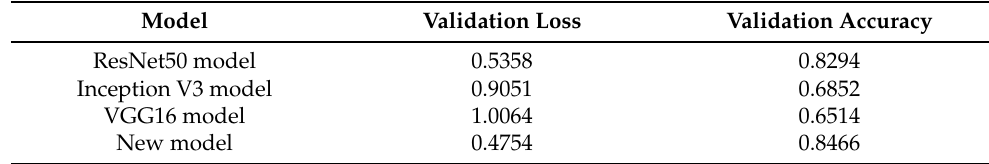
Table 6. Validation accuracy and the validation loss of noisy CIFAR-10 dataset performed with four different classification models.